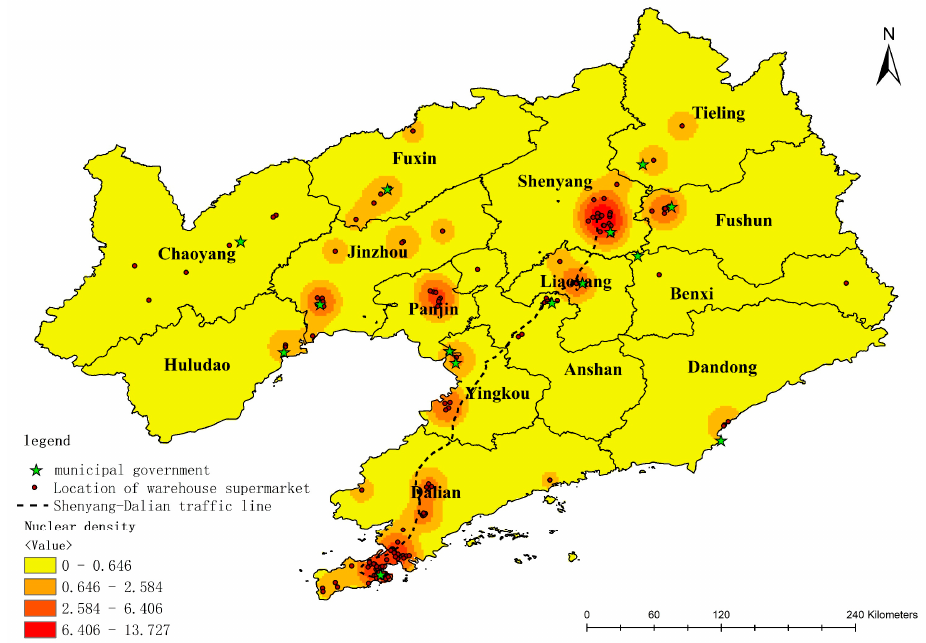
Figure 9. Number Distribution and Nuclear Density of Warehouse Supermarkets in Liaoning Prov-